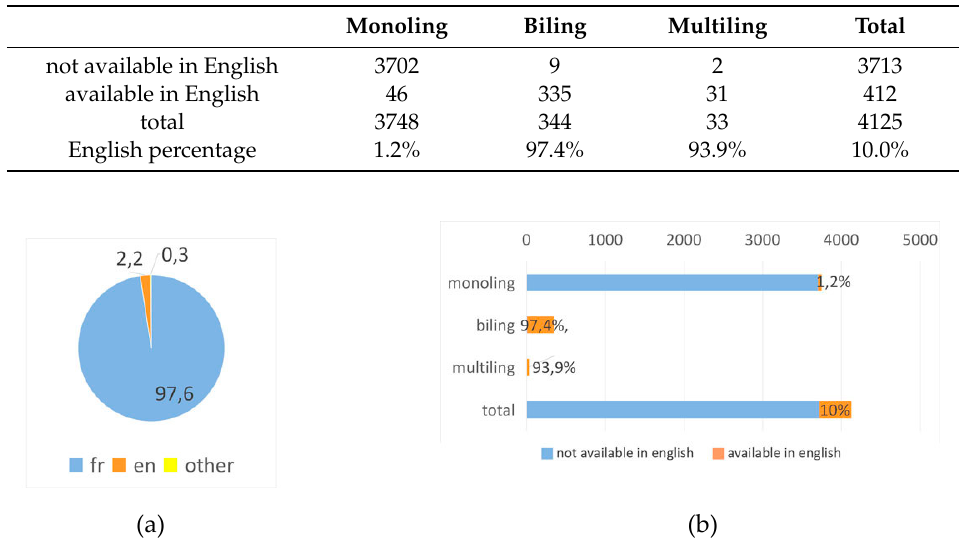
language availability bar chart.